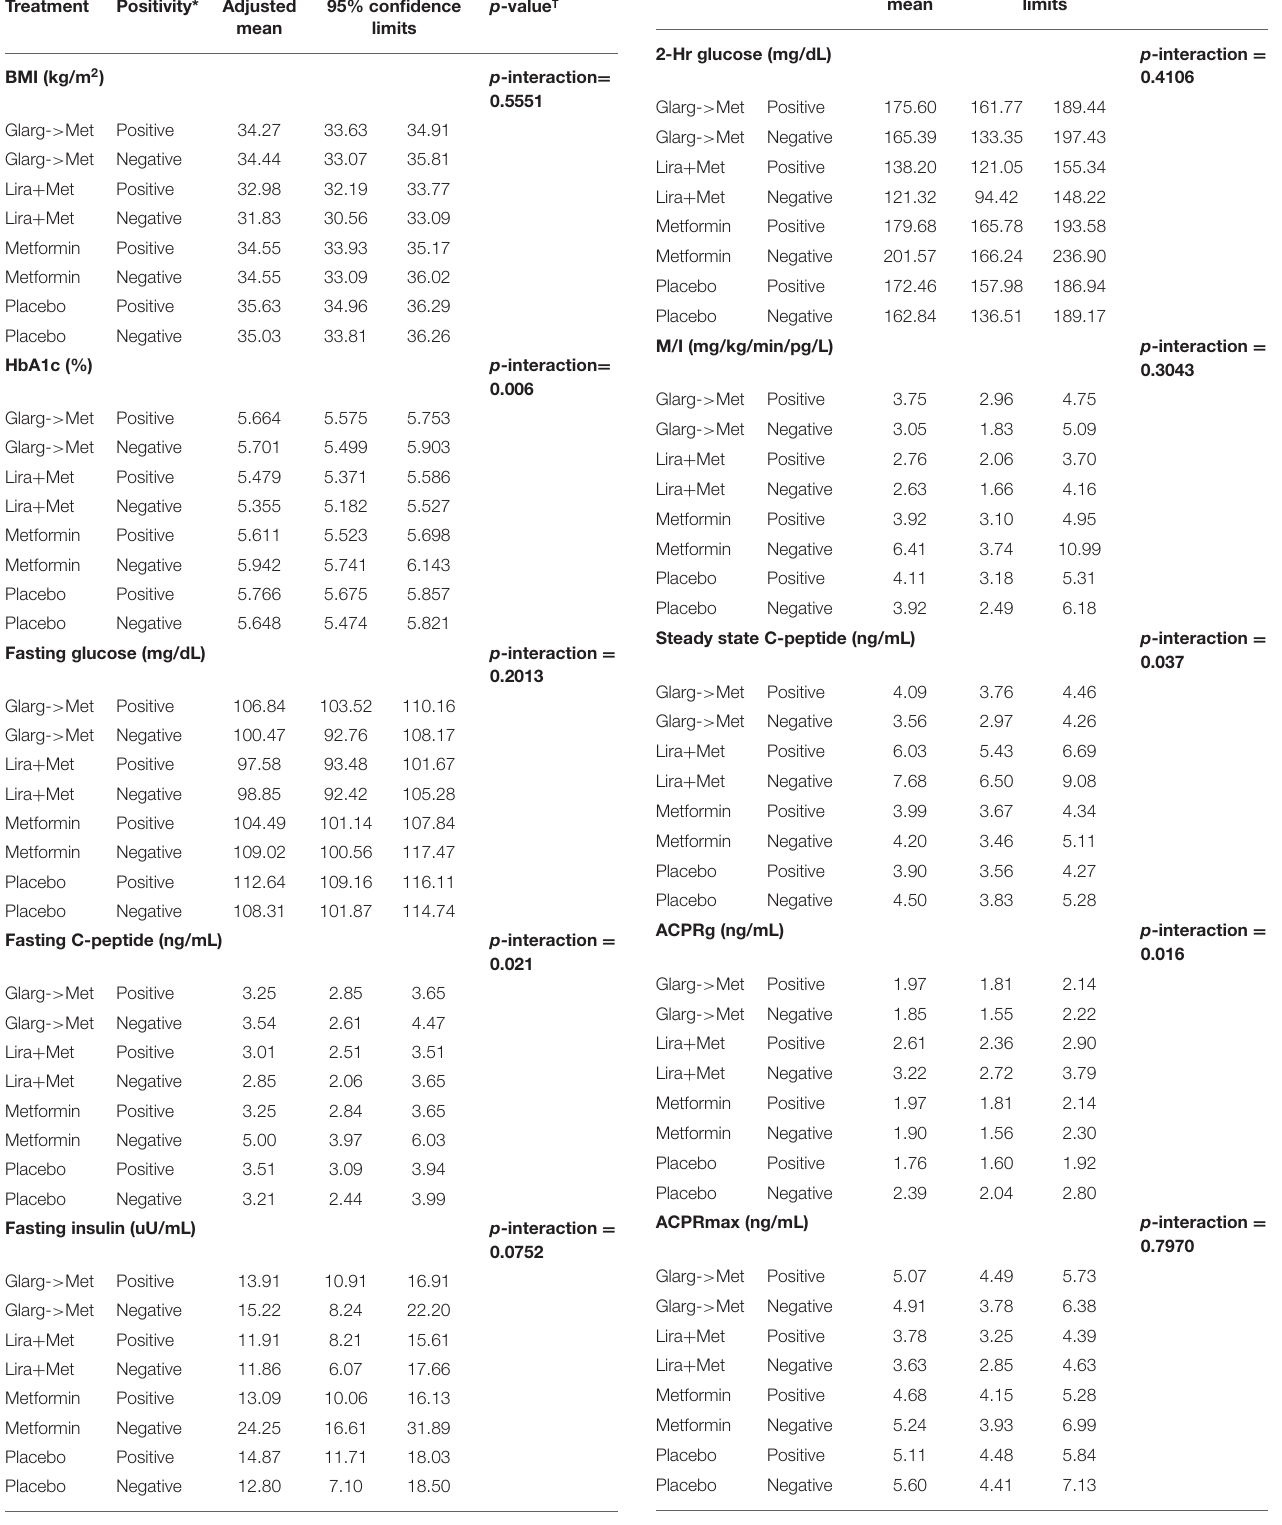
TABLE 5 | Adjusted means of β -cell functional outcomes illustrating interactions between T cell positivity and treatment group. Treatment Positivity*